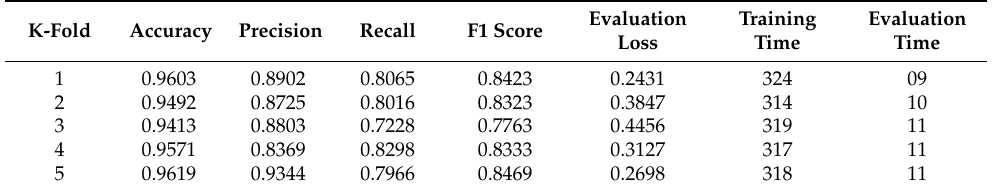
Table 13. DistilBERT—Amazon Alexa Review dataset.